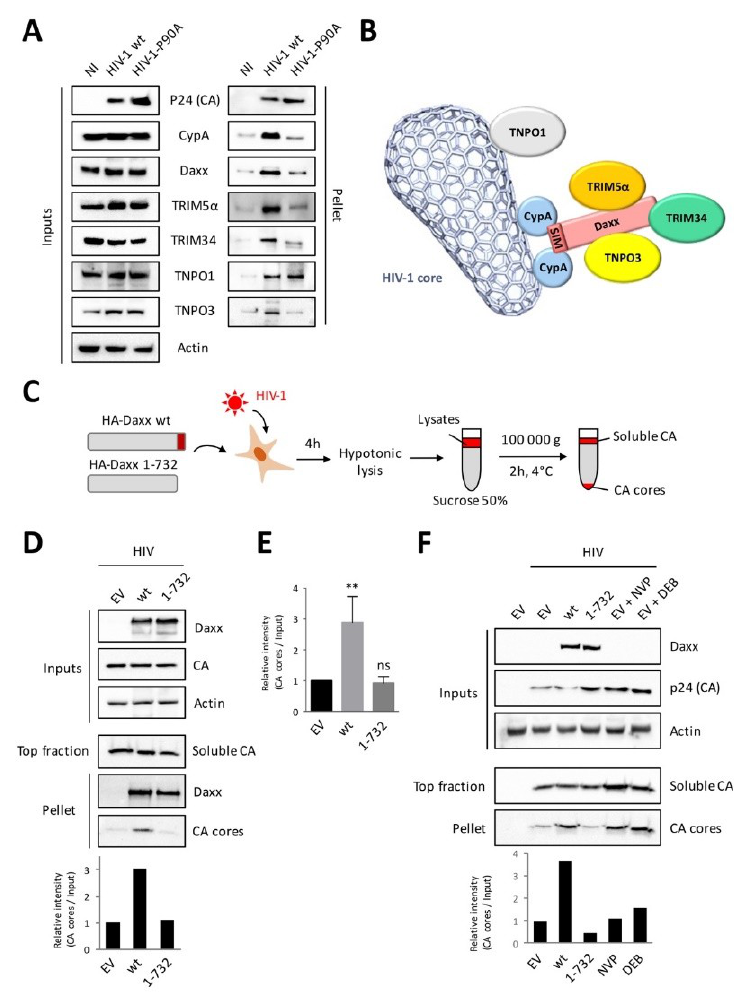
Figure 4. Daxx associated to incoming HIV-1 cores and interferes with their uncoating in a SIM-dependent manner. ( A ) HEK293T cells were transduced with VSV-G pseudotyped HIV-1 wt or P90A at a MOI of 10 for 2 h. Cells were lysed using hypotonic lysis bu ff er and a dounce homogenizer, and then the lysates were layered onto a 50% sucrose cushion and ultracentrifuged at 100,000 × g for 2 h, in order to pull down intact cores (recovered in the pellet). Equal amounts of HIV-1 cores were analyzed by Western blot in order to evaluate the presence of p24 (CA), CypA, Daxx, TRIM5 α , TRIM34, TNPO1, and TNPO3; ( B ) This cartoon represents a model where Daxx interacts with CypA bound to incoming HIV-1 capsids and coordinates the formation of a multiprotein complex containing TRIM5 α , TRIM34, and TNPO3. TNPO1, which is not within this complex, binds directly to the viral core [23]; ( C ) Schematic representation of fate-of-capsid assay; ( D ) HEK293T cells were transfected with empty vector (EV) or with plasmids encoding HA-tagged Daxx wt or the 1-732 Daxx mutant. Twenty-four hours post transfection, cells were transduced with VSV-G pseudotyped HIV-1 at a MOI of 10 for 4 h. Cells extracts were prepared as in (A) and ultracentrifuged at 100,000 × g for 2 h on a 50% sucrose cushion, in order to separate soluble CA (top fraction) from intact cores (pellet). Both fractions were analyzed by Western blot using anti-p24 and Daxx antibodies. Quantification of band intensity shows the amount of CA cores relative to inputs (EV set to 1); ( E ) This graph shows the mean band intensity (amount of CA cores relative to inputs) ± SD of three independent experiments. ** p < 0.01; ns, non-significant, as determined by one-way ANOVA with Bonferroni post hoc test; ( F ) The same experimental procedure as in panel (D) was followed, but some cells transfected with EV were treated with nevirapine (NVP) or Debio 025 (DEB025) before HIV-1 transduction. Quantification of band intensity shows the amount of CA cores relative to inputs (EV set to